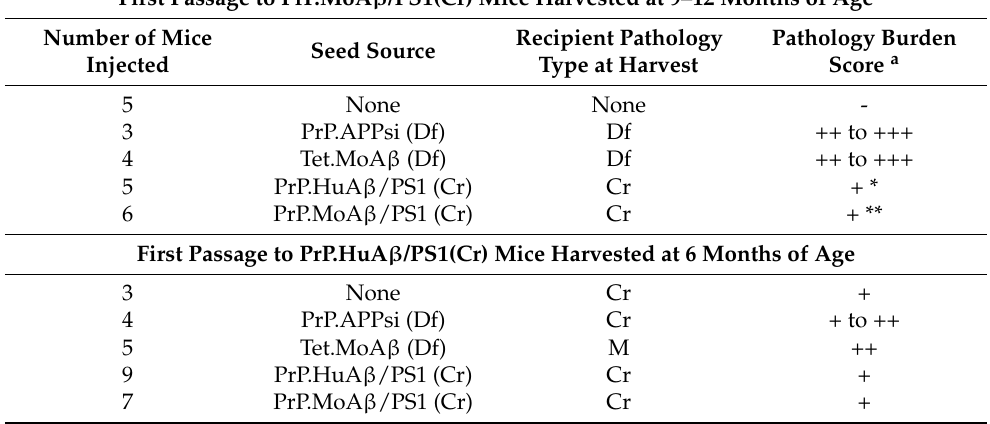
Table 2. First passage cohort data and results; Cr-core plaques, Df-diffuse plaques, M-mixed. First Passage to PrP.MoA β /PS1(Cr) Mice Harvested at 9–12 Months of Age Recipient Pathology Pathology Burden Number of Mice Seed Source Type at Harvest Score a Injected 5 None None PrP.APPsi (Df) Df ++ to +++